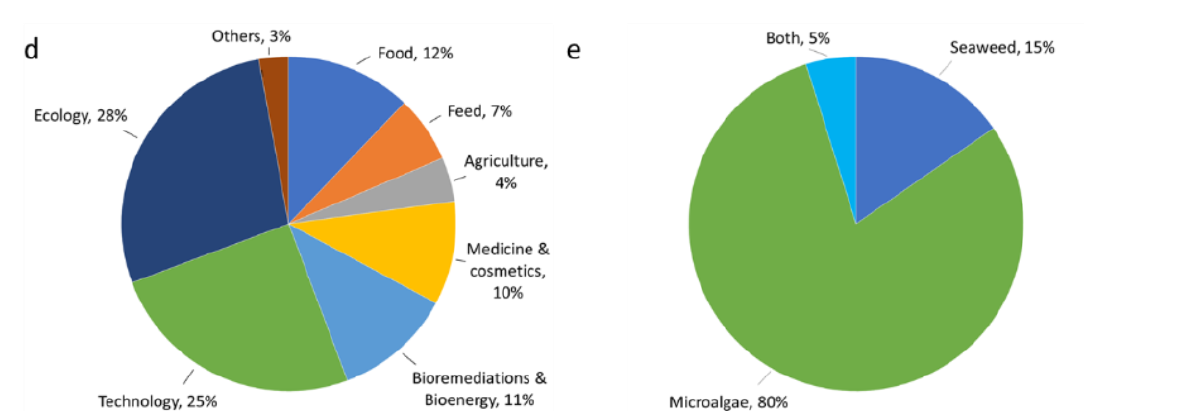
Figure 4. Overview regarding EU funding for algae-related projects. ( a ) Funding per year for microalgae-related projects in the European Commission, within the framework programs FP4- H2020; ( b ) the number of H2020 projects led, per country; ( c ) EC projects funding per leading country; ( d ) main areas of the projects funded; and ( e ) the proportion of projects connected to microalgae or seaweed